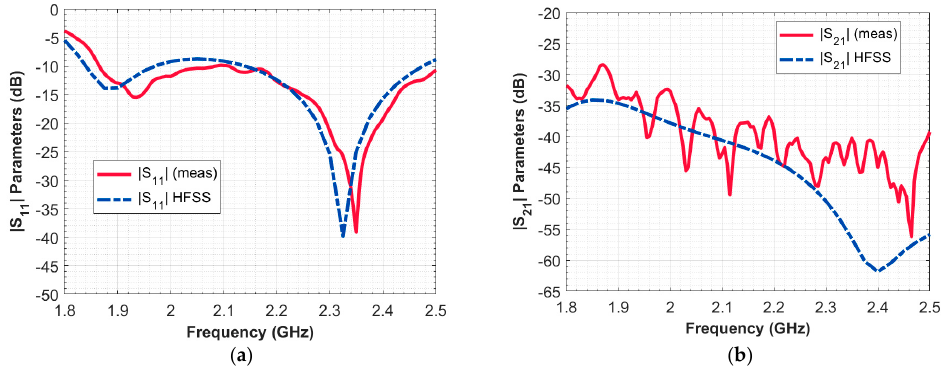
Figure 7. Cross-pol radiation patterns calculated at the frequencies 1.9, 2.2, and 2.5 GHz respectively. ( a ) Radiation pattern on the ϕ = 0 ◦ , ( b ) ϕ = 90 ◦ .